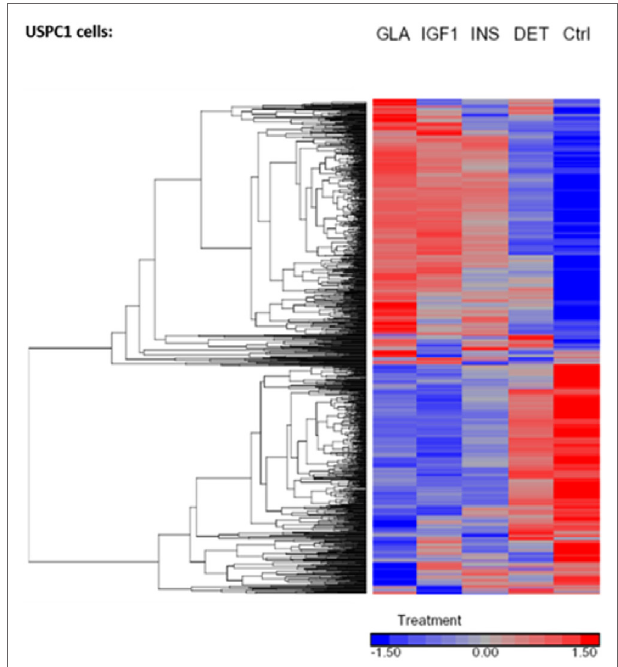
FigUre 5 | Hierarchical clustering map of differential gene expression in USPC-1 cells. Heatmaps of microarray results in the USPC-1 cell line after treatment with insulin glargine, detemir, IGF1, and regular insulin. The figure depicts a heatmap of differentially expressed genes (FC > 1.5 or <− 1.5). The scale below indicates the relative changes in gene expression represented by red and blue colors. Upregulated genes are shown in red and downregulated genes are shown in blue. FC, fold